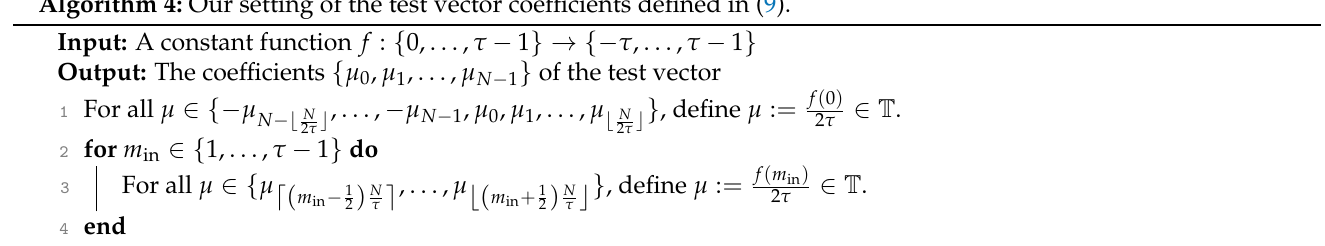
Algorithm 4: Our setting of the test vector coefficients defined in